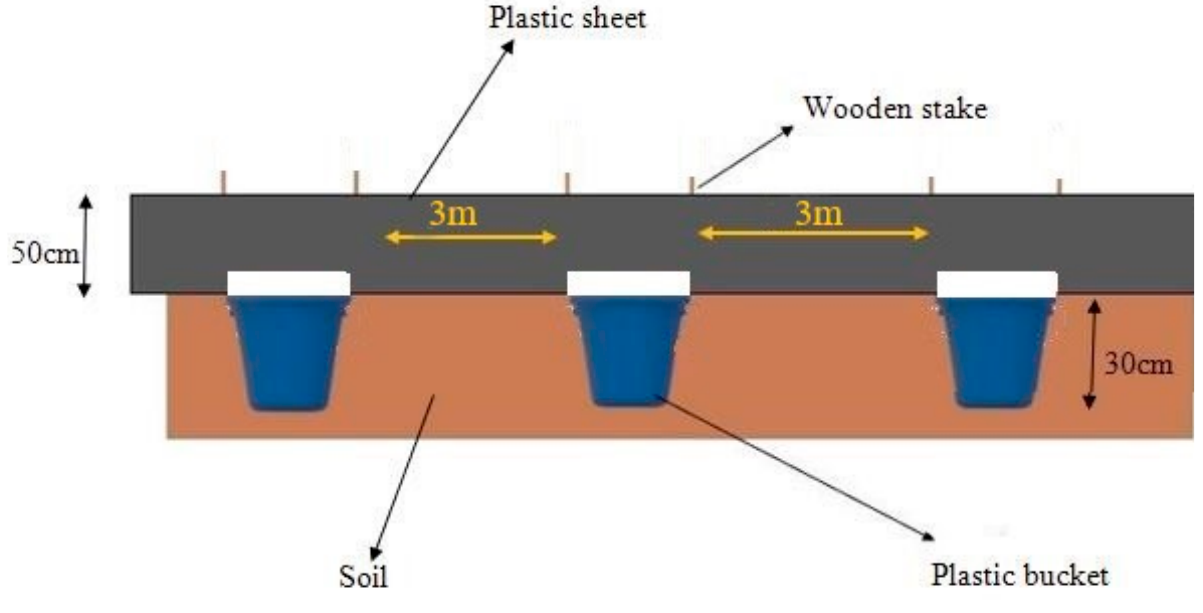
Figure 2. Sketch of drift fence and pitfall trap layout.